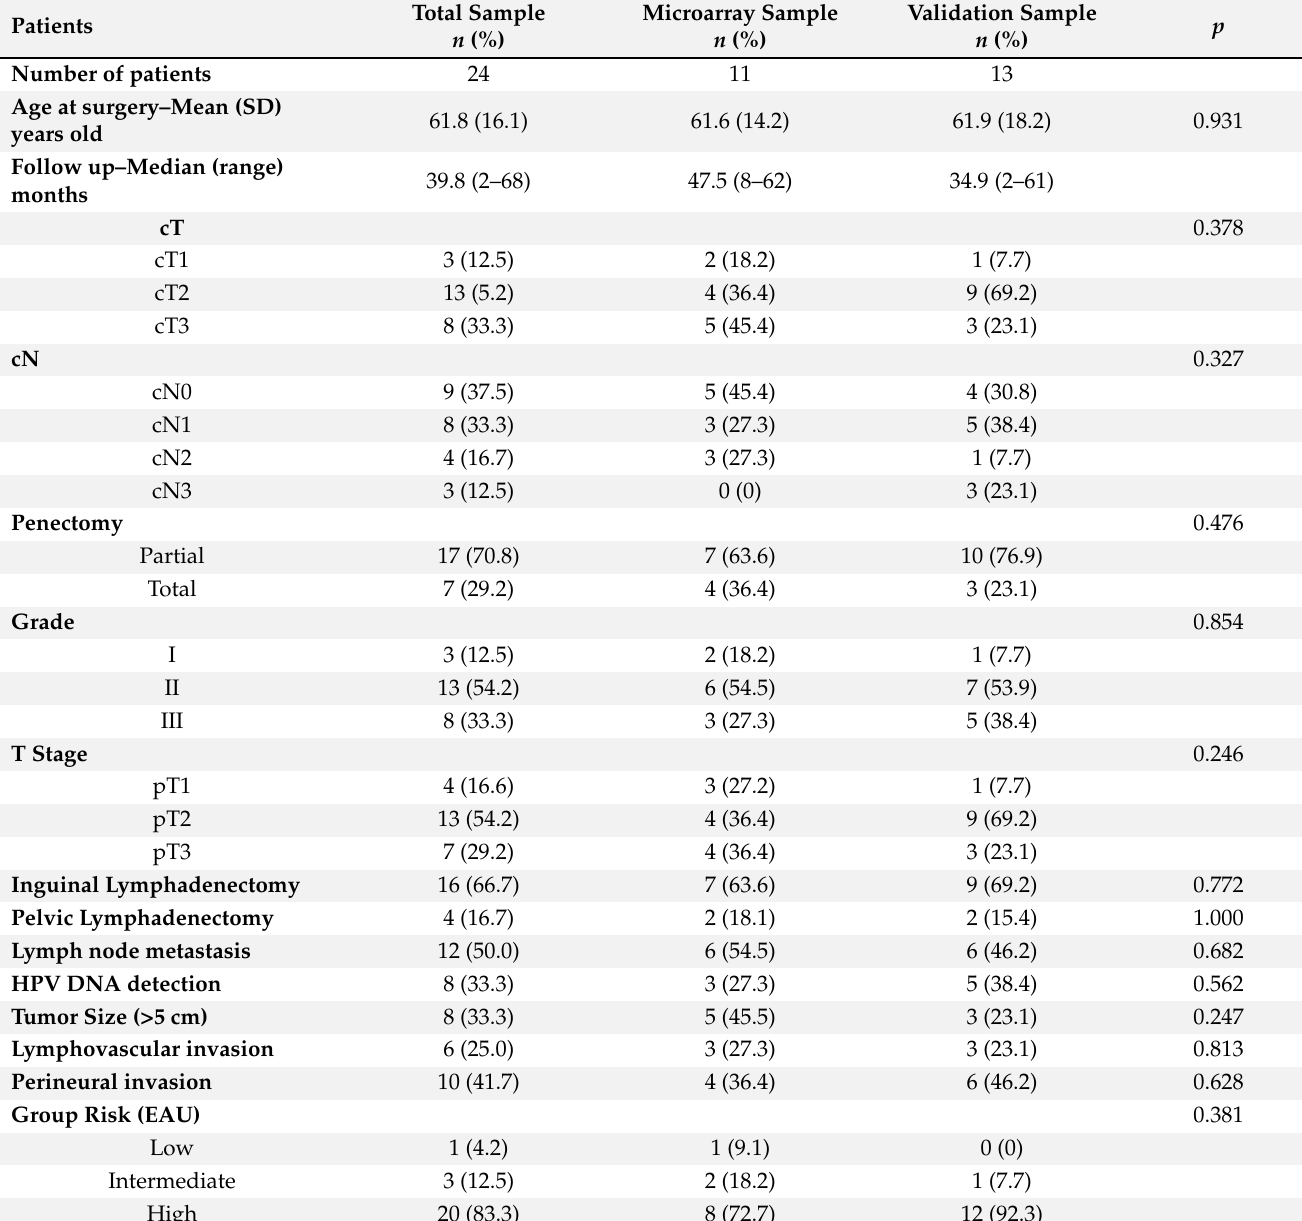
Table 1. Clinicopathological characteristics of PeC patients separated by each set of